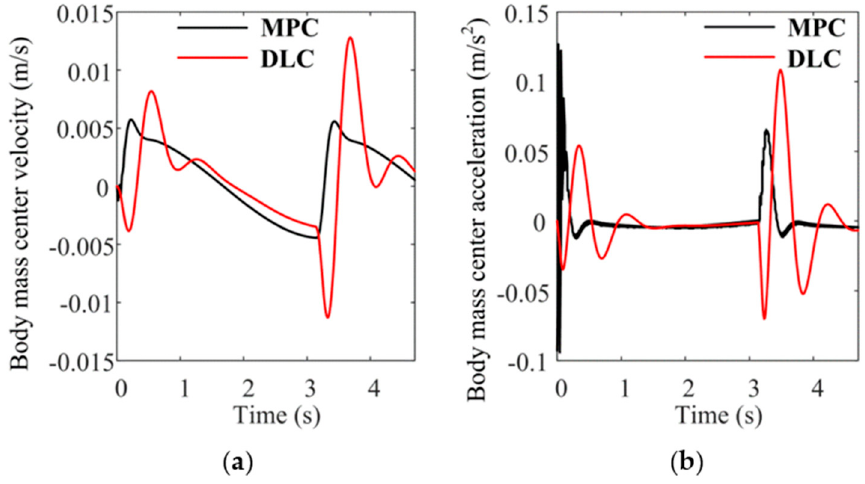
Figure 12. Body mass center velocity and acceleration. ( a ) Body mass center velocity; ( b ) Body mass center acceleration.